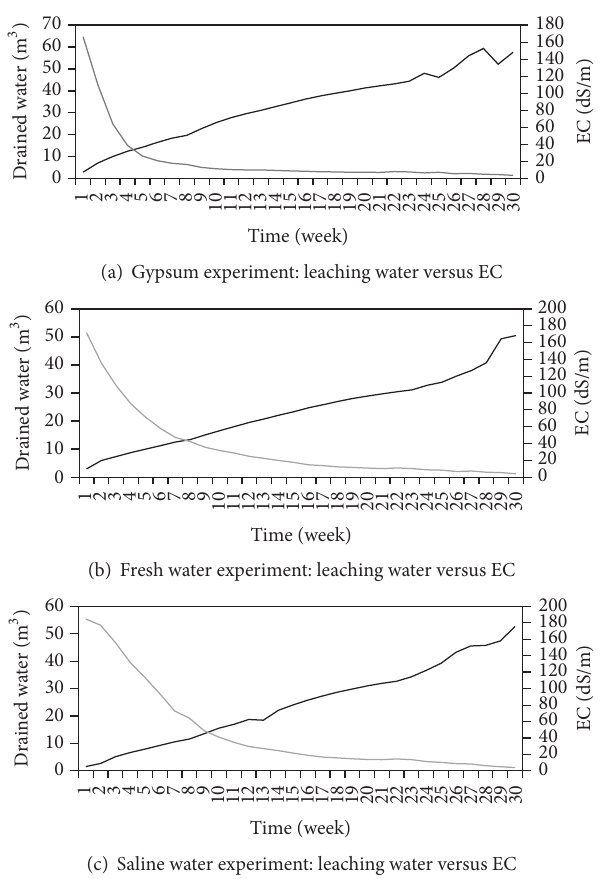
Figure 3: Electrical conductivity and quantities of drained water recordedduringtheexperiment((a)gypsum,(b)freshwater,and(c) saline water). The black line represents the leaching water quantity (m 3 ), and the gray line is the